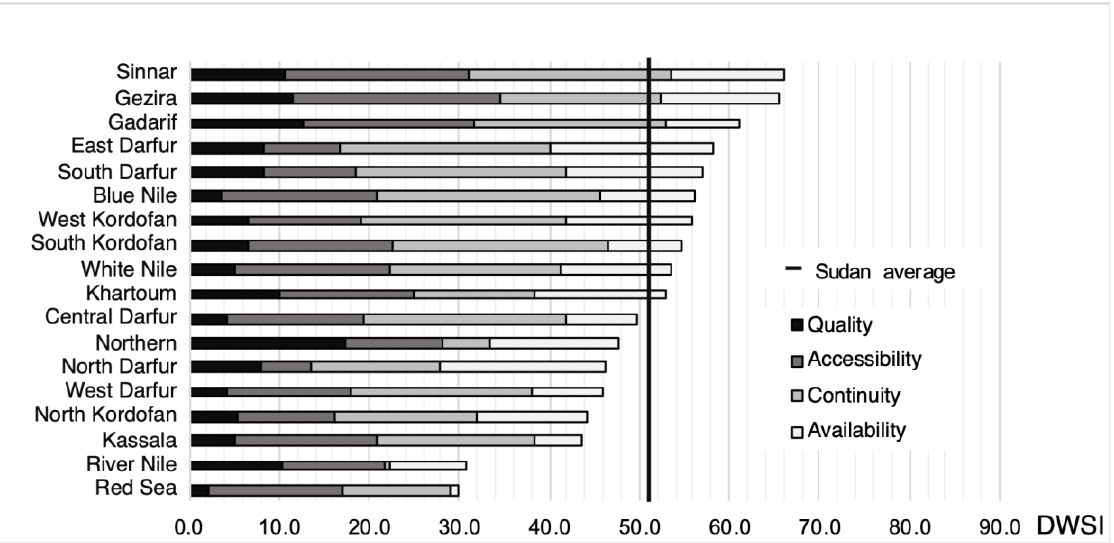
Figure 2. Ranking of the 18 states according to their historical DWSI. Vertical line indicates DWSI average across all states.